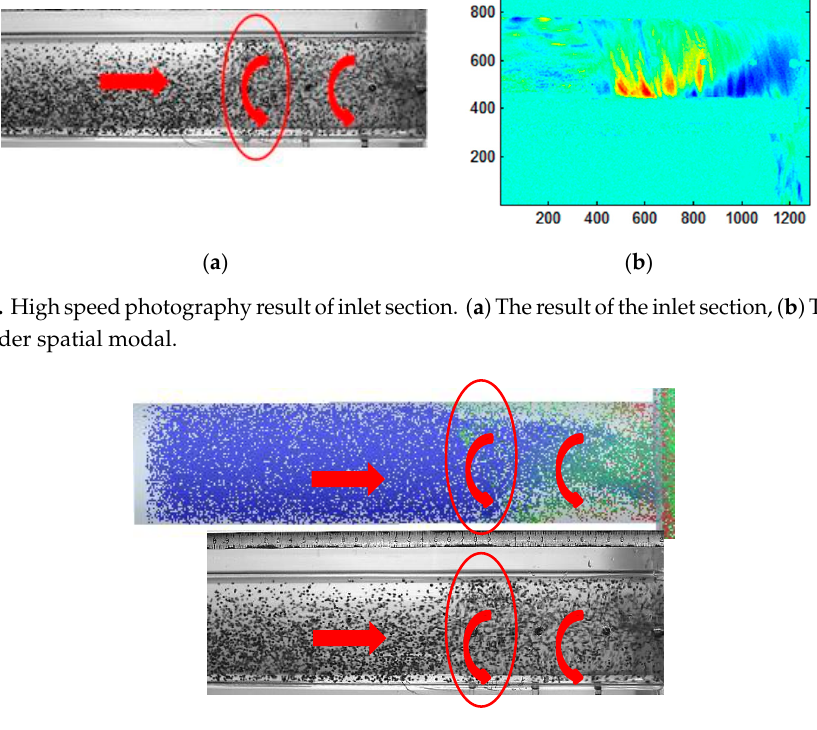
Figure 18. High speed photography result of inlet section. ( a ) The result of the inlet section, ( b ) The result of first-order spatial modal.